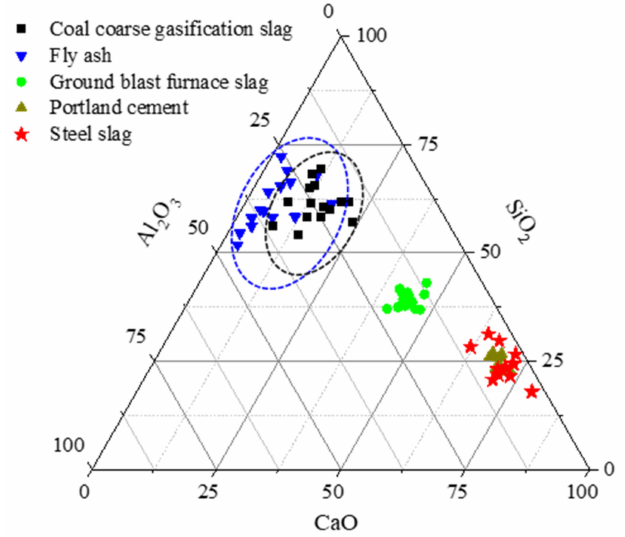
Figure 2. Composition comparison of different mineral